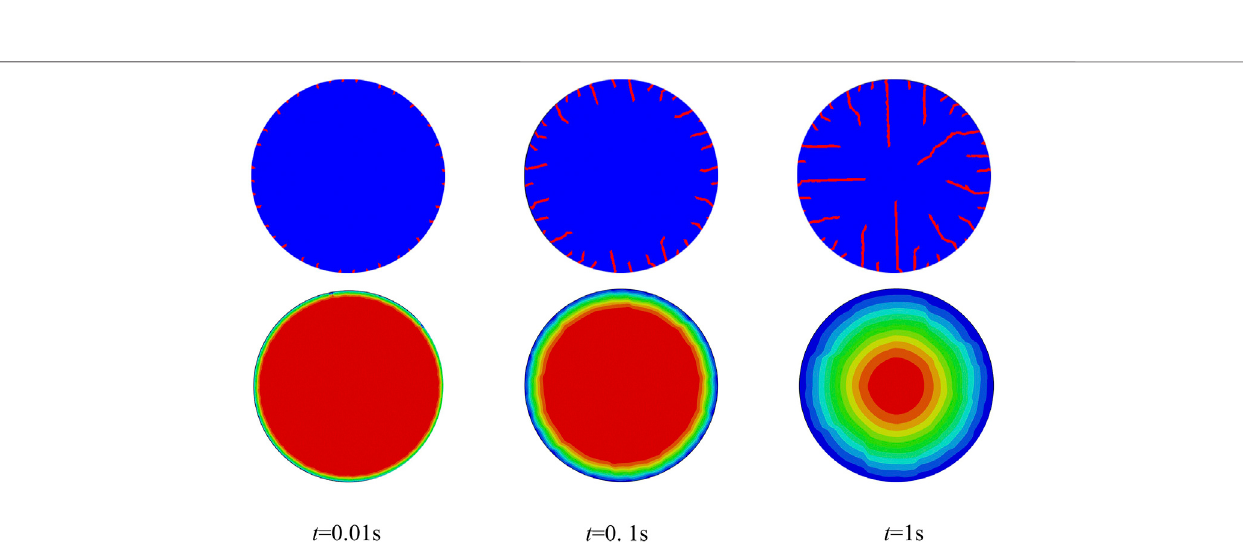
Frontiers in Materials |